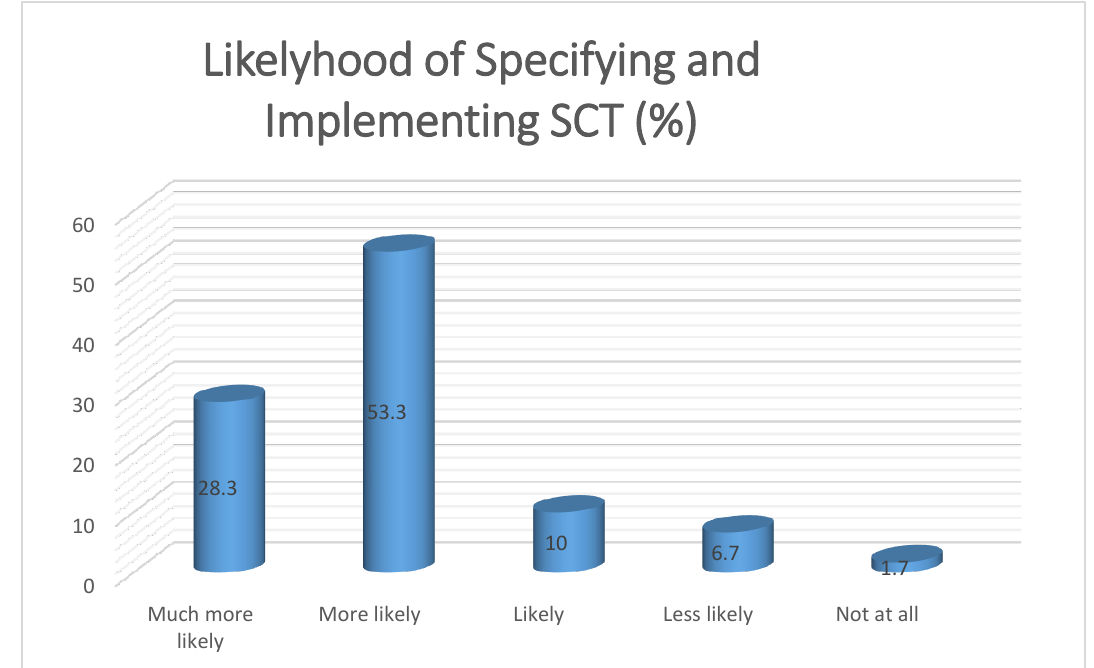
Figure 5. The likelihood of specifying and implementing SCT.